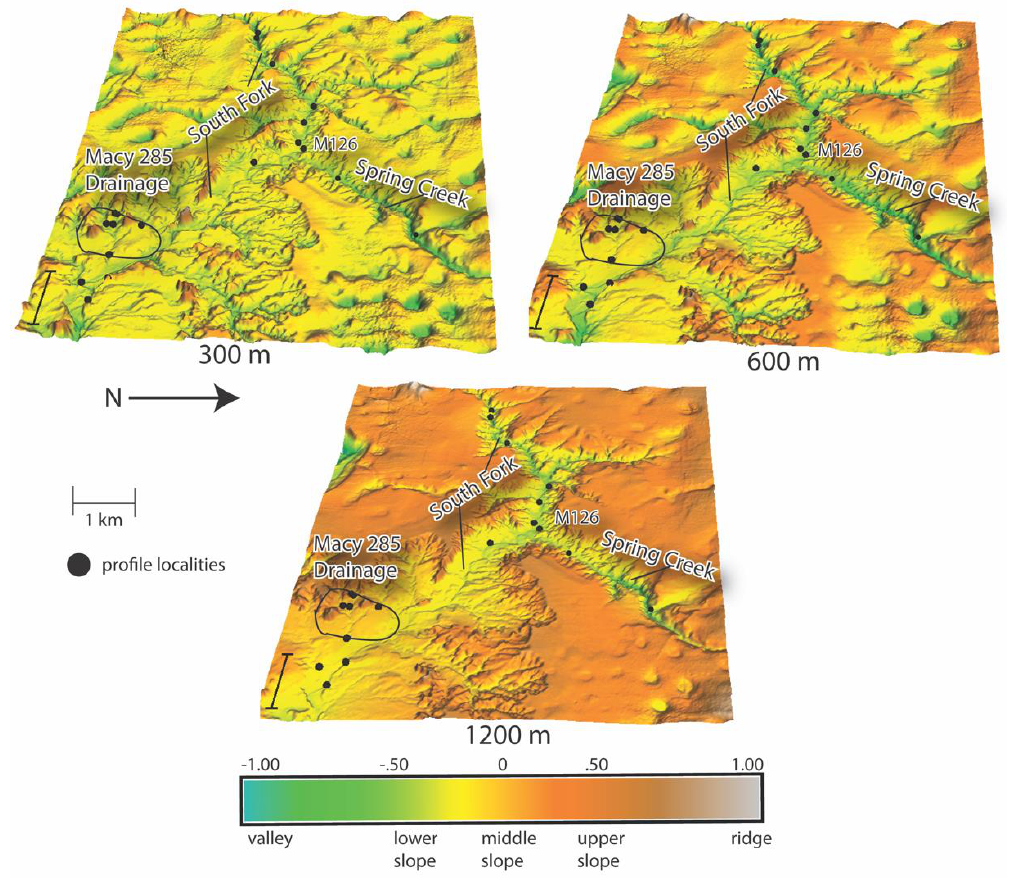
Figure 6. Maps generated classifying landscapes using differing neighborhood search radii (300, 600, and 1200 m) for the South Fork drainage in the eastern escarpment breaks of the Southern High Plains, Texas.